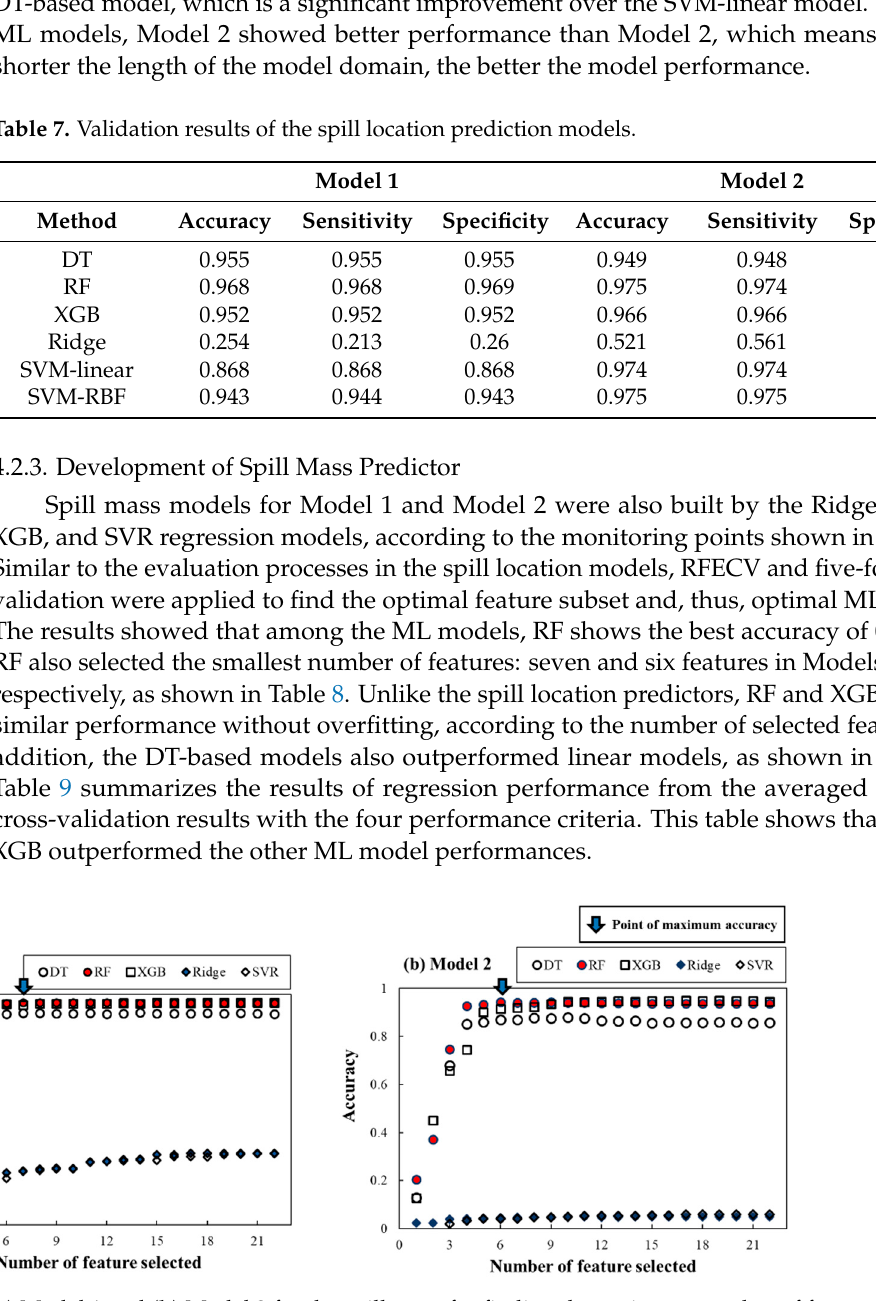
Figure 8. RFECV results of ( a ) Model 1 and ( b ) Model 2 for the spill mass for finding the optimum number of features for each ML model.